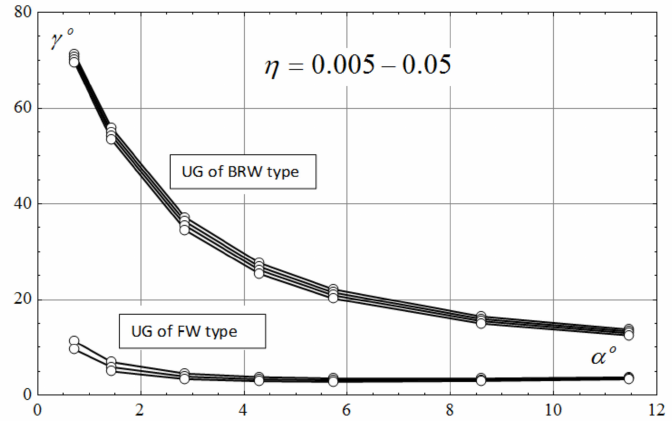
Figure 9. Angle of trajectory versus angle of attack for BRW- and FW-type gliders for different values of relative differential buoyancy ( V 0 = 0.042 m 3